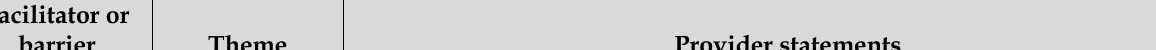
Table 3 Representative PCP statements related to facilitators and barriers to CET use aligned with behavioral evidence- based medicine (EBM) steps Facilitator